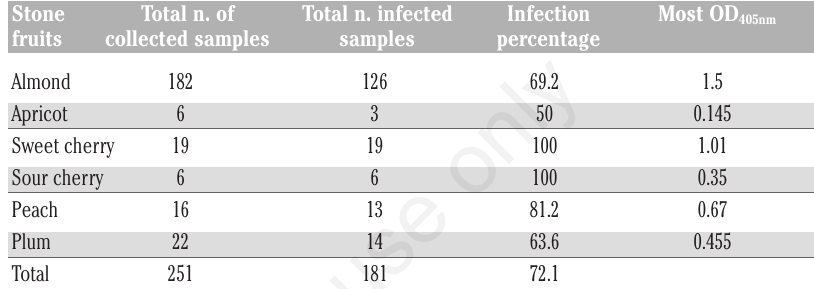
Table 4. Infection percentage of PDV on various collected samples of stone fruits.